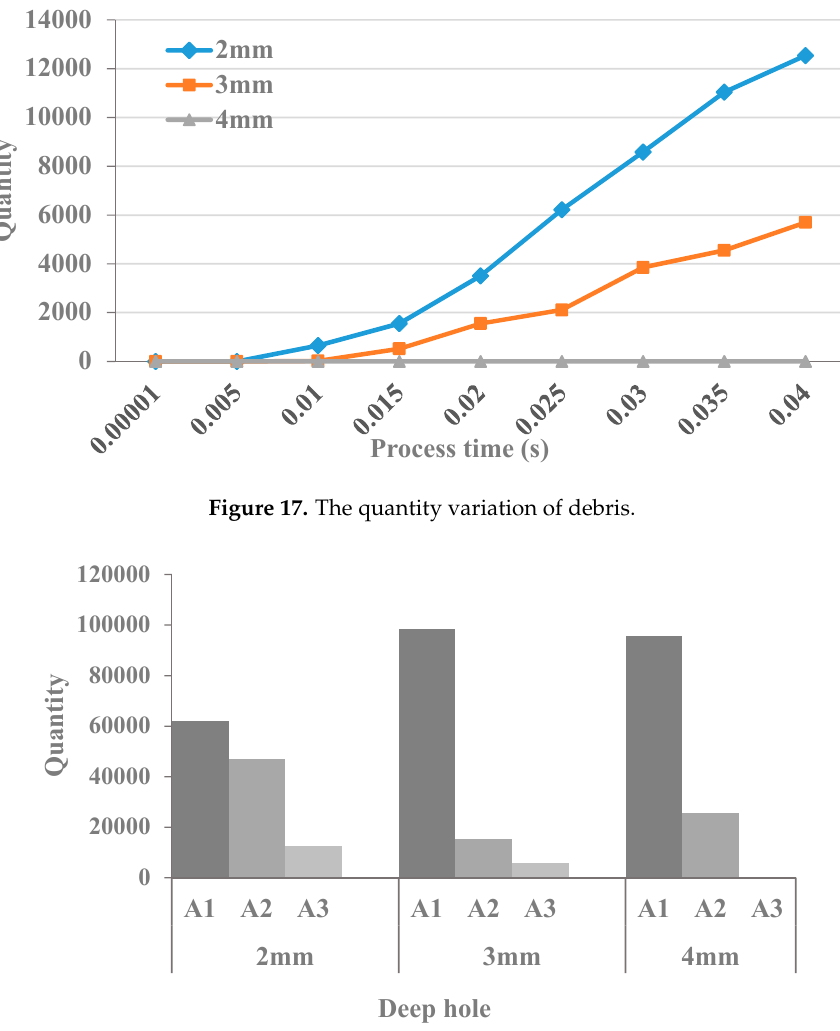
Figure 18. The quantity of debris distribution.